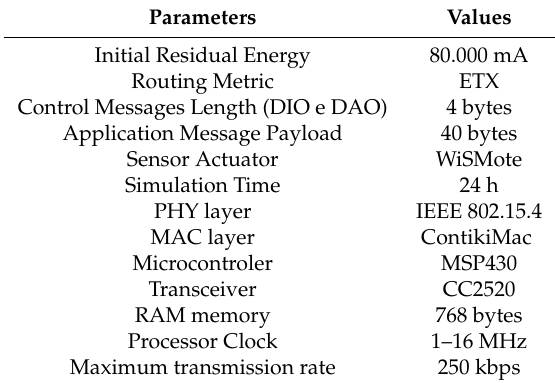
Table 2. RPL parameters and nodes’ configuration on Cooja